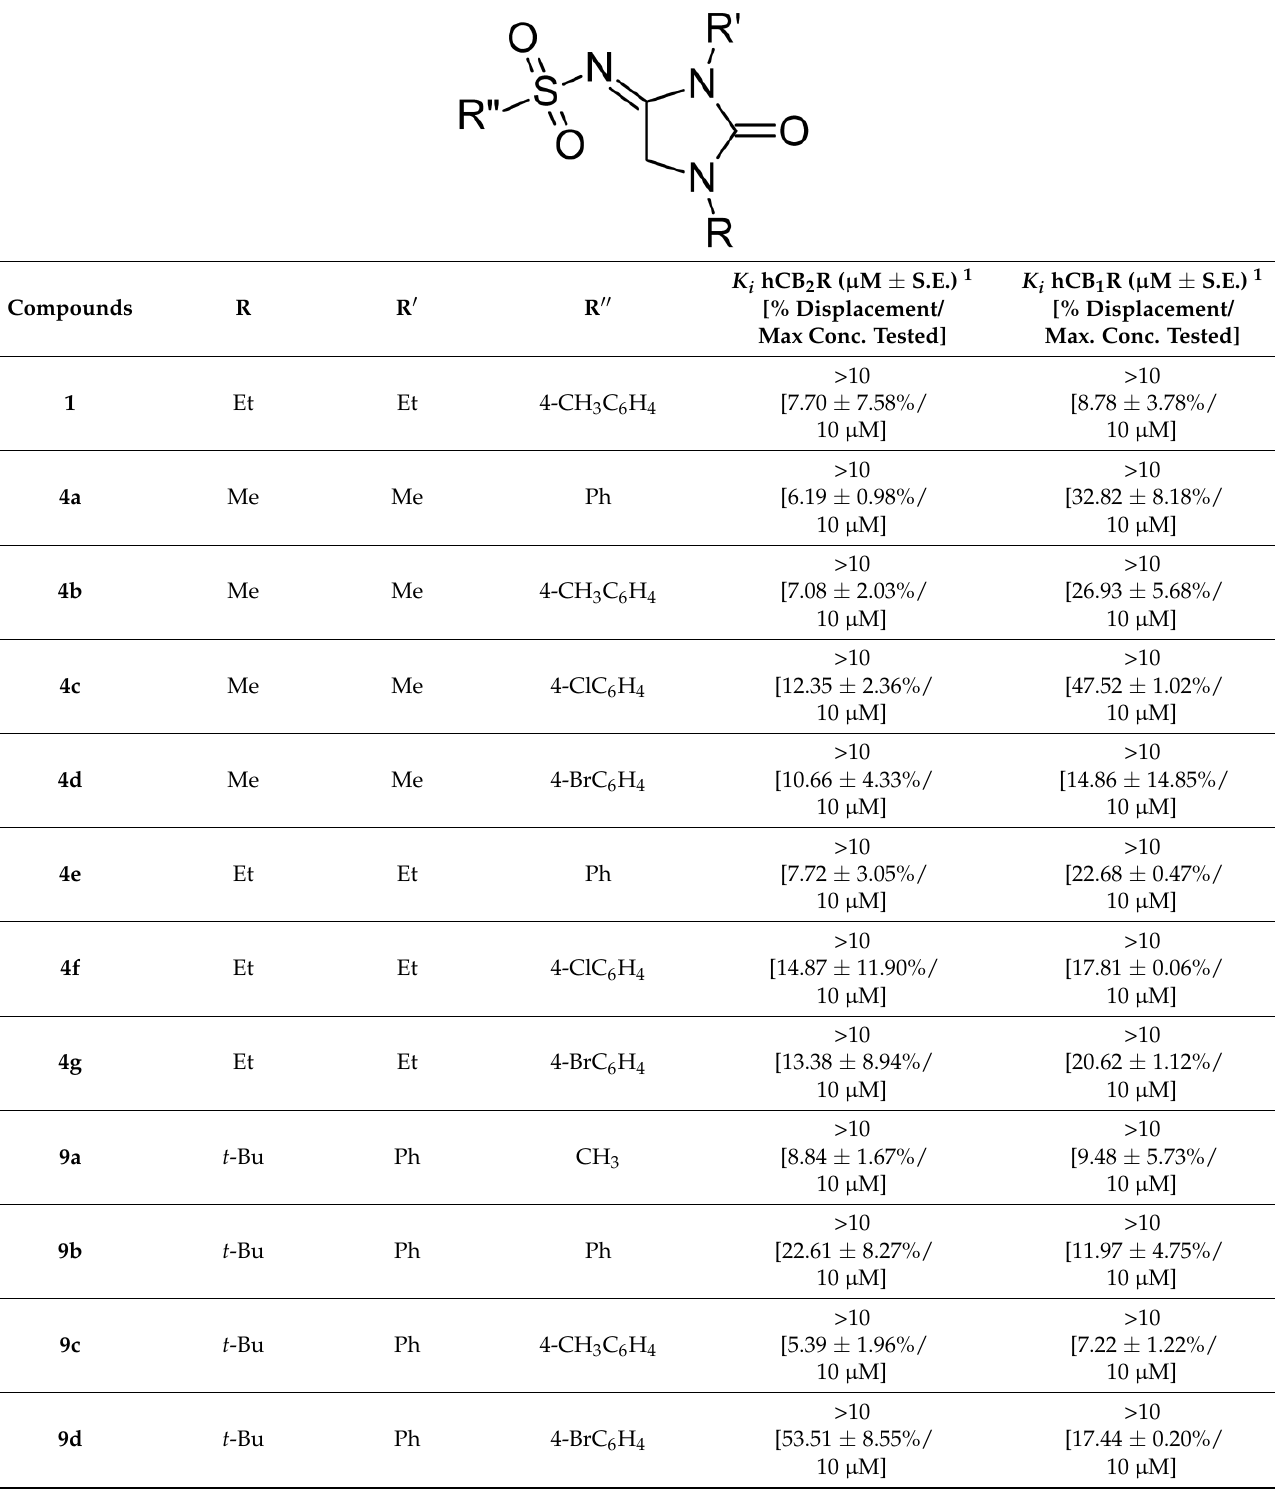
Table 1. Affinity values for hCB1R and hCB2R of compounds of general formula.